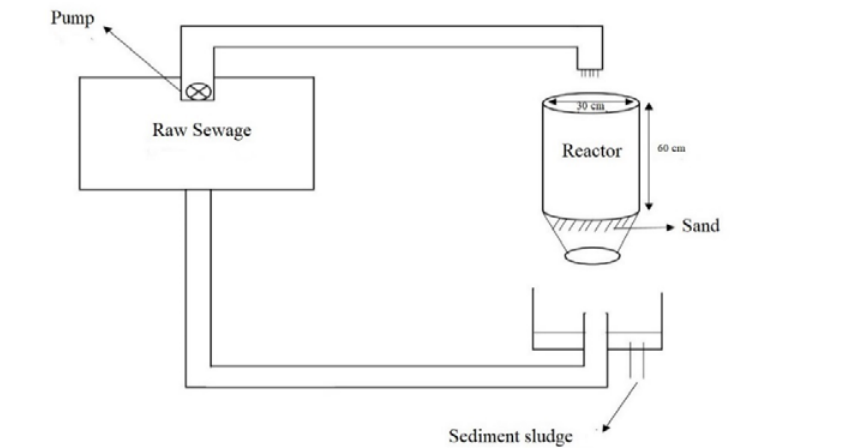
Figure 1. Reactor design in this study